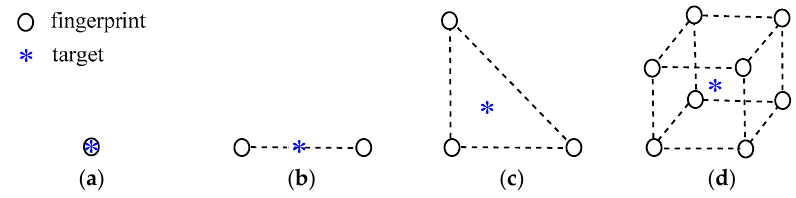
Figure 3. The relationship between target and fingerprints: ( a ) K = 1; ( b ) K = 2; ( c ) K = 3; ( d ) K = 8. Figure 4 is the positioning error of five targets at different 3-D positions using WKNN algorithm, for K increases from 1 to 8. When K = 4, the positioning error of target 1 is minimal. When K = 3, the